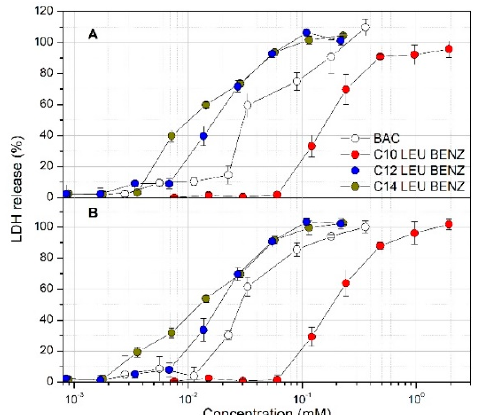
Figure 3. LDH release (%) of Caco-2 (intestinal epithelial) ( A ) and Calu-3 (airway epithelial) ( B ) cell lines after exposure to different concentrations of the quaternary ammonium leucine surfactants (C10 LEU BENZ, C12 LEU BENZ and C14 LEU BENZ) and the reference compound BAC. Dots represent the mean and bars the standard error ( n = 4).